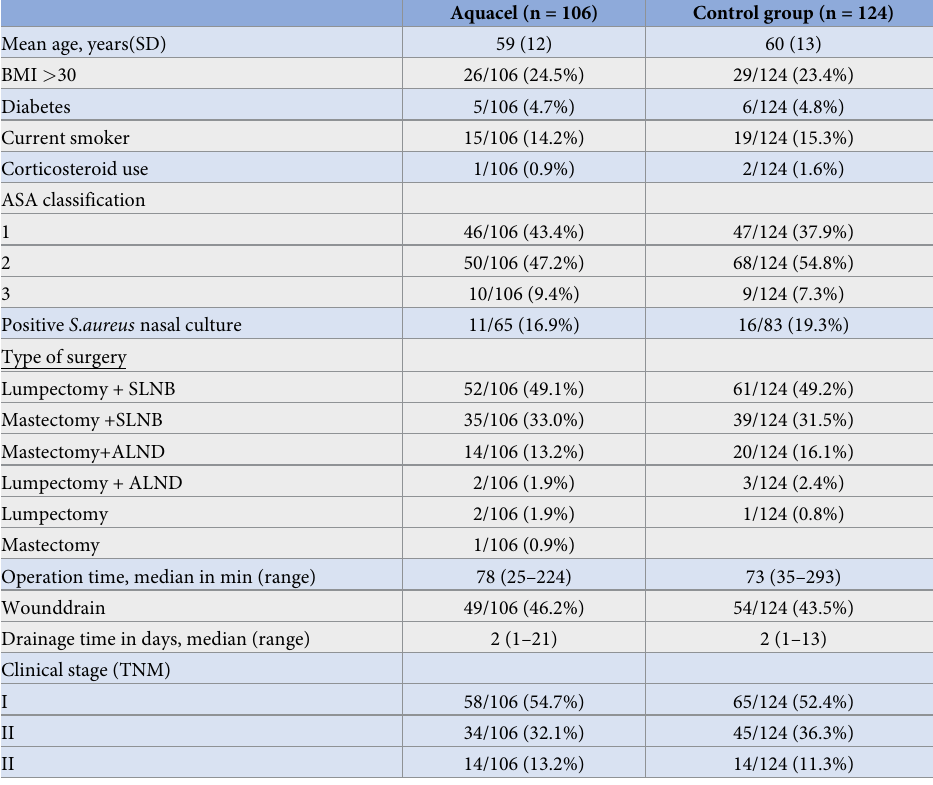
Table 1. Baseline